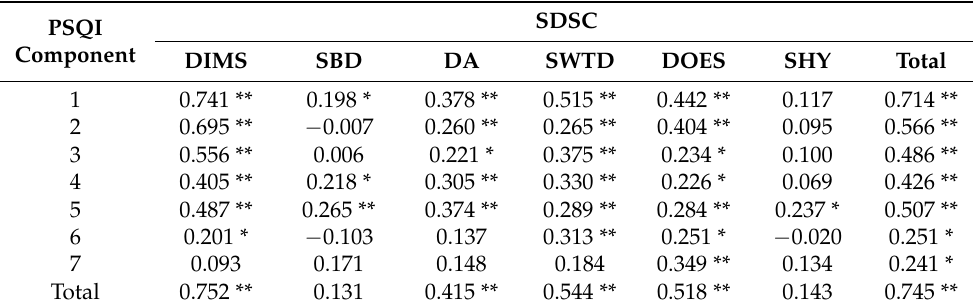
Table 4. Correlation between SDSC and PSQI. PSQI